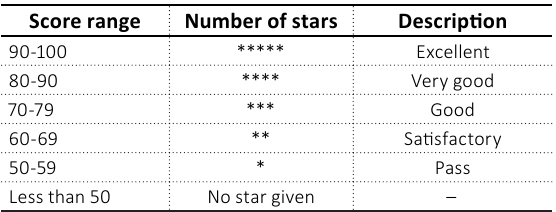
Table 1. CG (corporate governance) star by the IOD (Thai Institute of